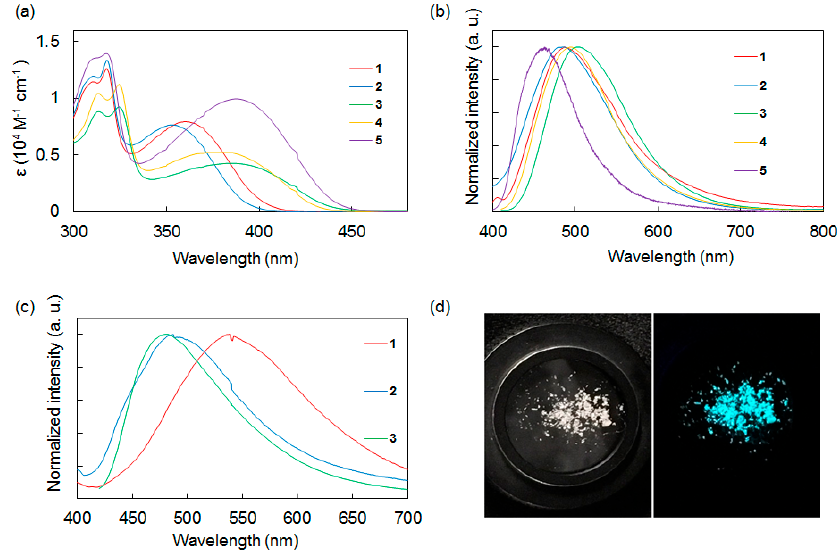
Figure 2. ( a ) UV-vis absorption spectra of 1 ‒ 5 in CH 2 Cl 2 . ( b ) Photoluminescence spectra of 1 ‒ 5 in CH 2 Cl 2 . ( c ) Photoluminescence spectra of 1 – 3 in the solid state. ( d ) Photographs of 2 in the solid state. CH 2 Cl 2 . ( c ) Photoluminescence spectra of 1 ‒ 3 in the solid state. ( d ) Photographs of 2 in the solid state. Left: under ambient light. Right: under UV light ( λ ex = 365 Left: under ambient light. Right: under UV light ( λ ex = 365 nm).